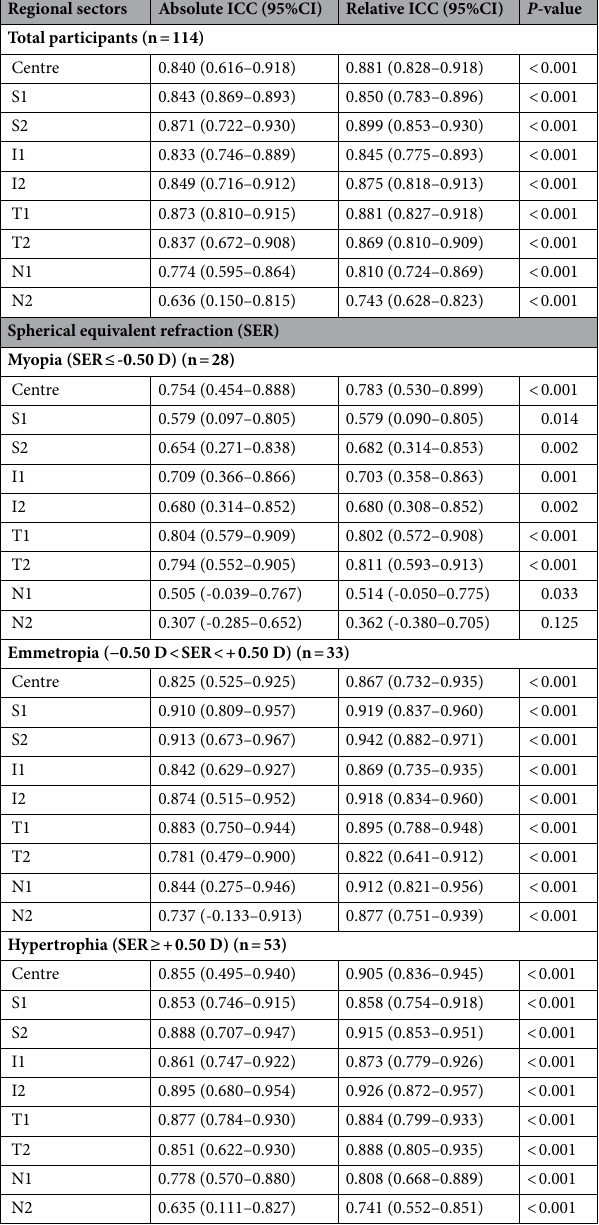
Table 3. Intra-class correlation coefficients between spectral-domain optical coherence tomography (SD-OCT) and swept-source optical coherence tomography (SS-OCT) in general and subgroup